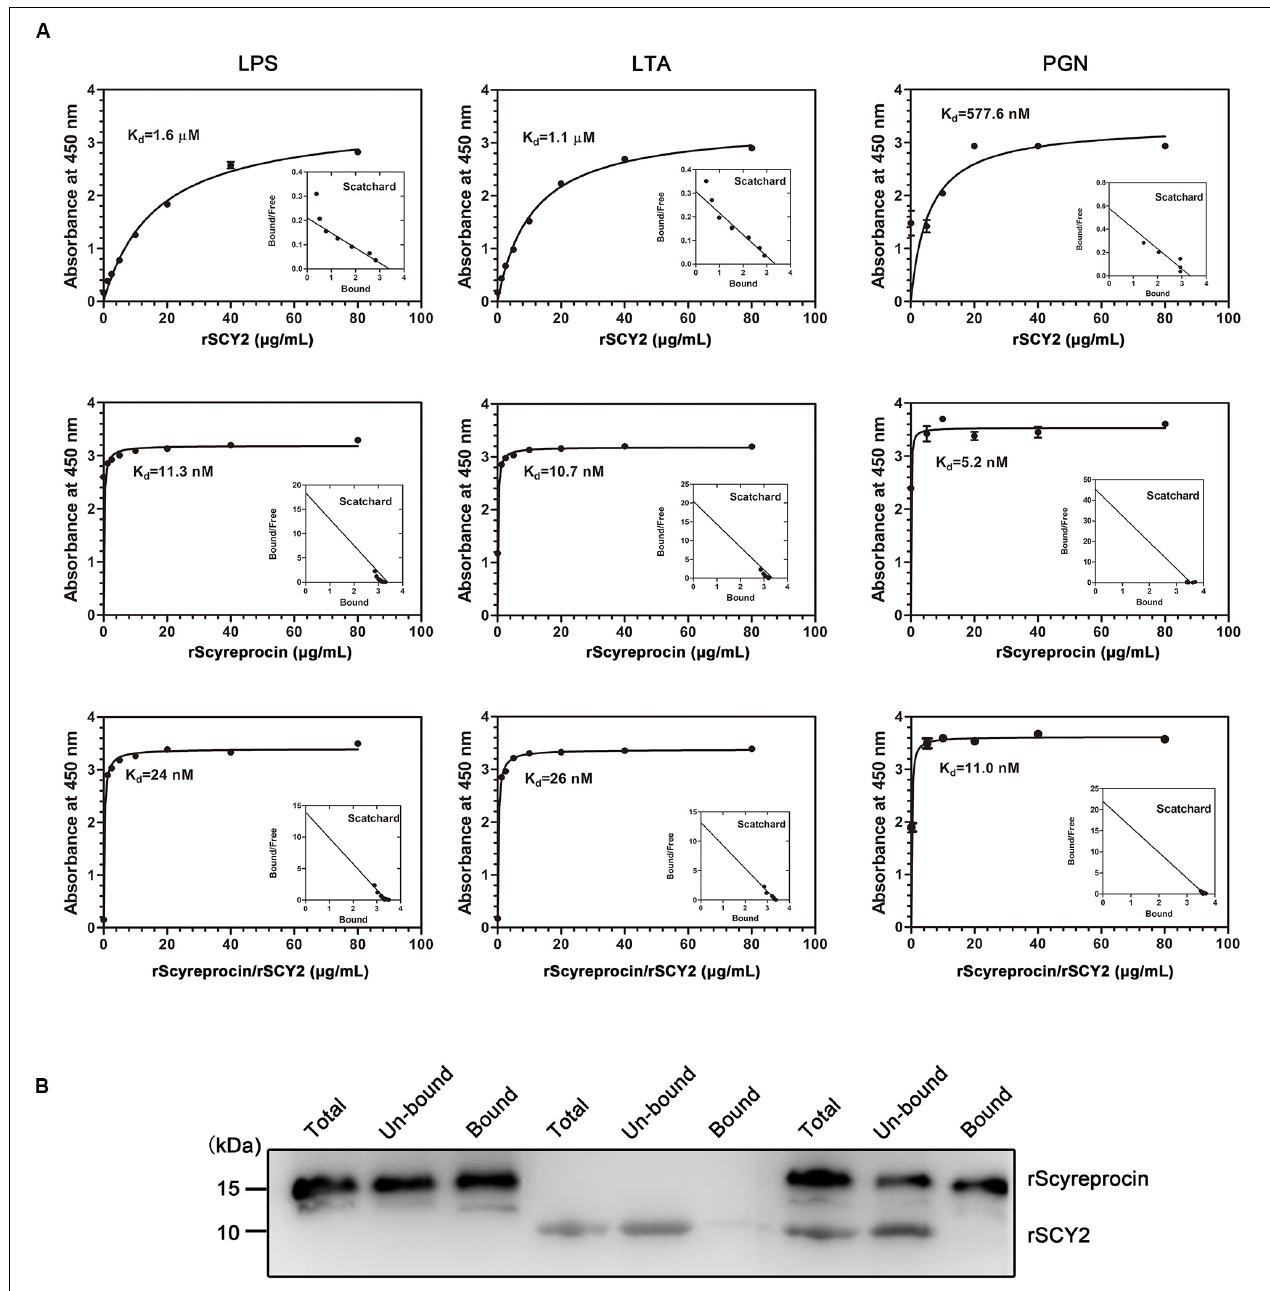
FIGURE 3 | Binding property of rScyreprocin, rSCY2, and rScyreprocin/rSCY2 to microbial associated molecules. (A) Binding affinity of rScyreprocin, rSCY2, and rScyreprocin/rSCY2 to LPS, LTA, and PGN assessed by ELISA, respectively. Data represent as means ± SEMs from three independent experiments ( n = 3). (B) Chitin binding capacity of rScyreprocin, rSCY2, and rScyreprocin/rSCY2. The total-, unbound-, and bound-fraction were analyzed by SDS-PAGE followed by Western blotting using anti-scyreprocin (1:1,000) and anti-SCY2 (1:1,000) mixture as primary antibody.